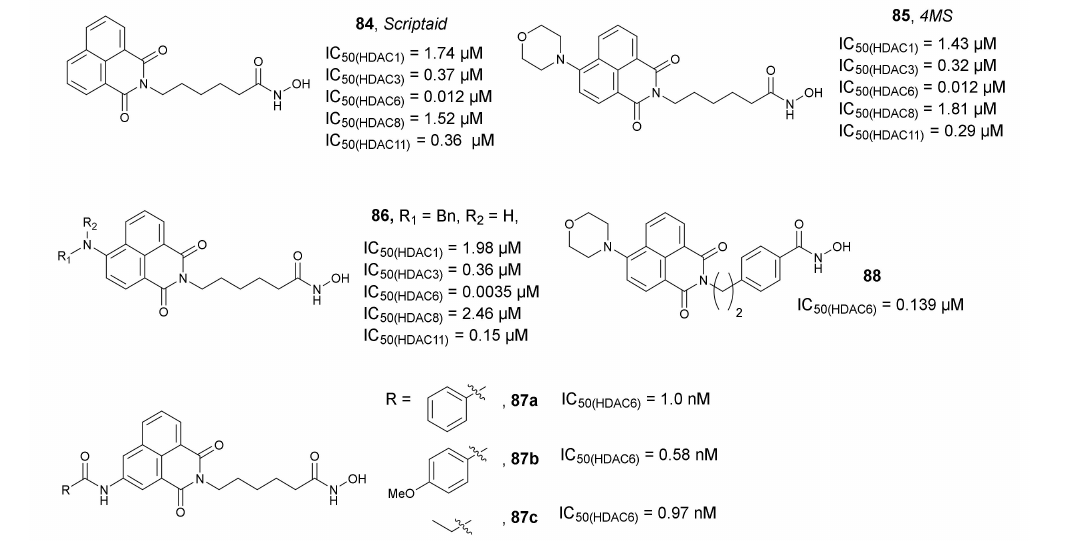
Figure 29. Chemical structures of compounds 84 – 88